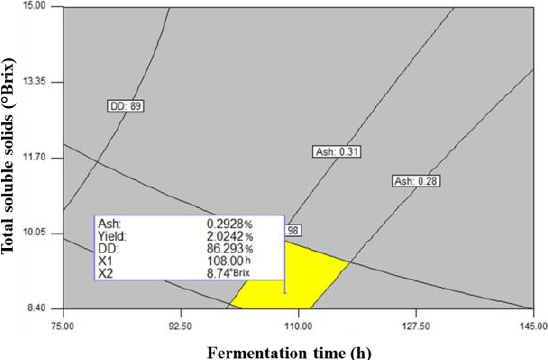
Figure 4. Region of the best combination of lactic fermentation (fermentation time/total soluble solids) for optimized chitosan production.